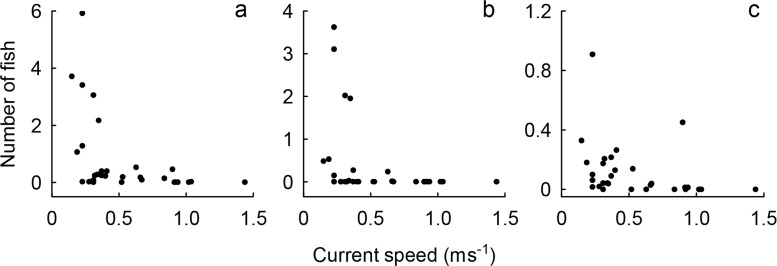
Activity of (a) pelagic associated fish, (b) sergeant fish and (c) trevallies over current speed.Number of fish represents the count of fish entering the recorded video frame during each sample (specimens per m2 and 45 min). The negative correlative relationship between fish activity and current speed indicates that pelagic fish at the studied location avoid strong currents.